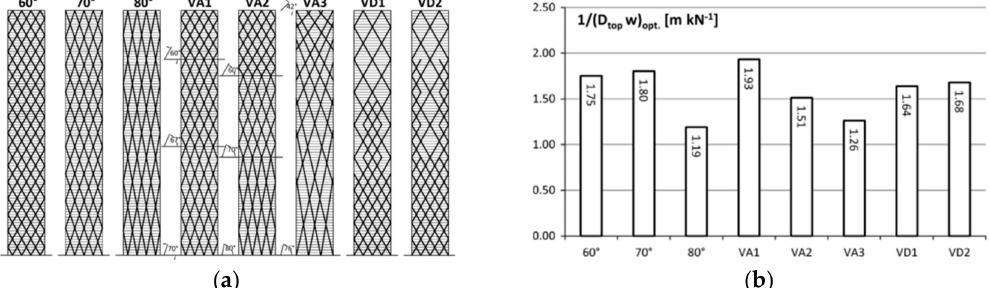
Figure 9. ( a ) Di ff erent geometrical patterns from Montuori et al. [32]: uniform-angle patterns (60 ◦ , 70 ◦ , 80 ◦ ), varying-angle patterns according to Moon approach (VA1, VA2) [12,30], varying-angle pattern according to Zhang approach (VA3) [31], variable-density patterns (VD1, VD2). ( b ) E ffi ciency parameters for the investigated solutions. Used with permission from Montuori et al. [32].